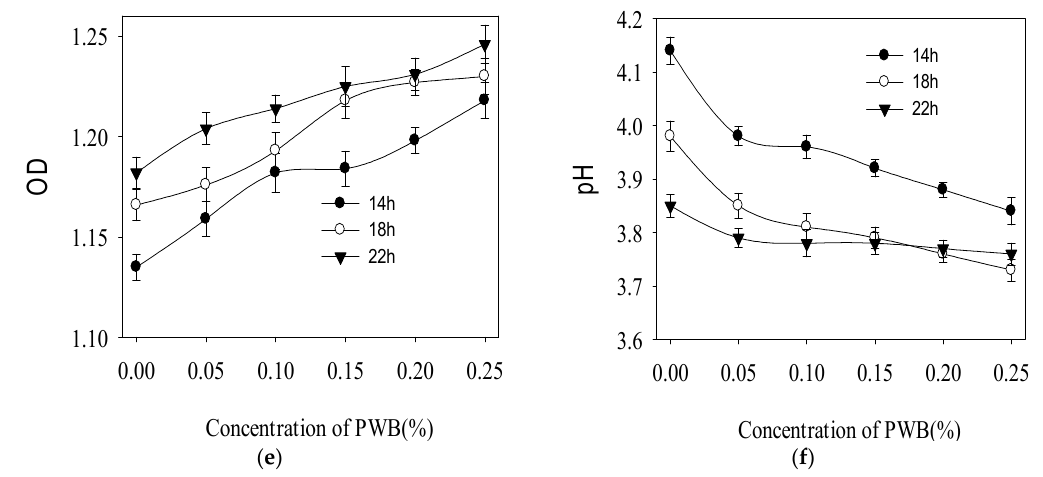
Figure 4. Effects of PWBs on the growth of Lactobacillus acidophilus LA5 ( a , b ), Bifidobacterium bifidum BB01 ( c , d ), and Lactobacillus bulgaricus LB6 ( e , f ). All values are represented as mean ± standard deviation ( n = 3).